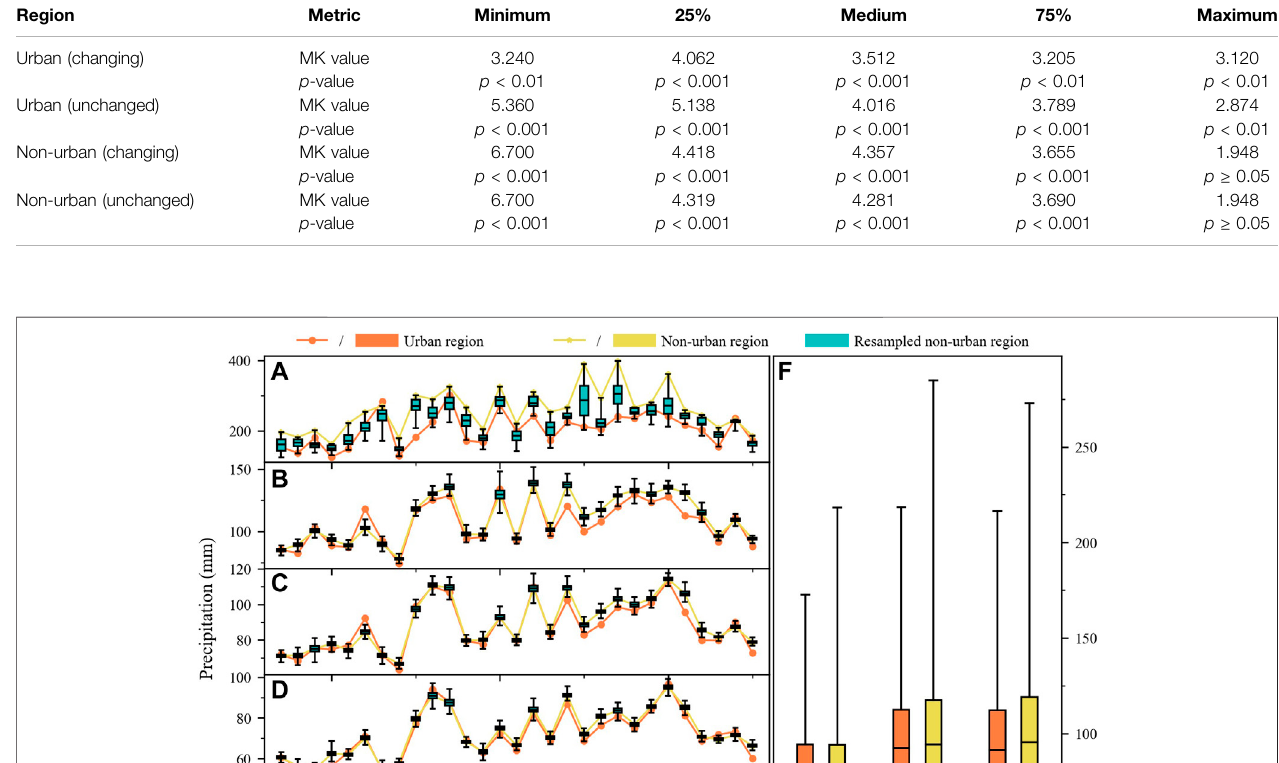
Frontiers in Earth Science |